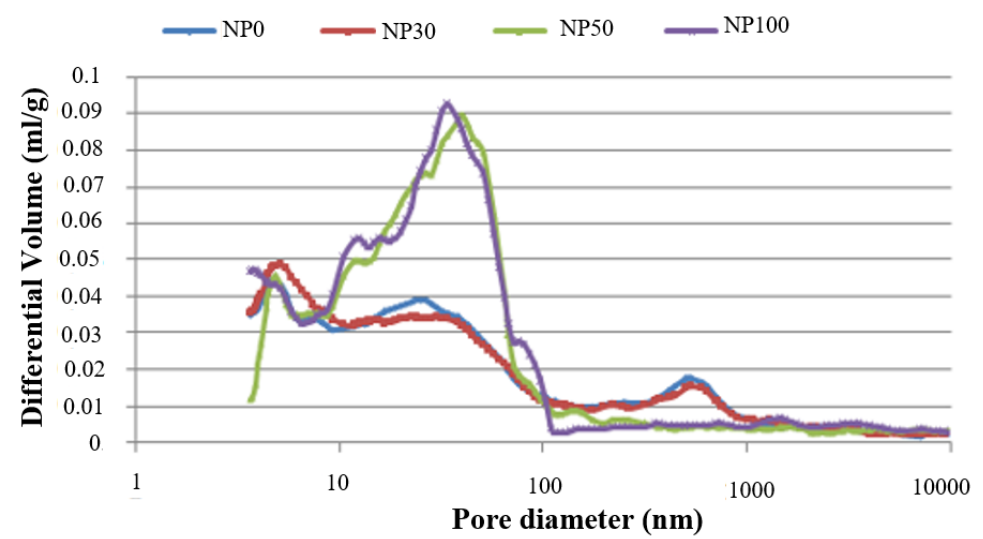
Figure 6. Pore size distribution for the different new pastes (NP ).